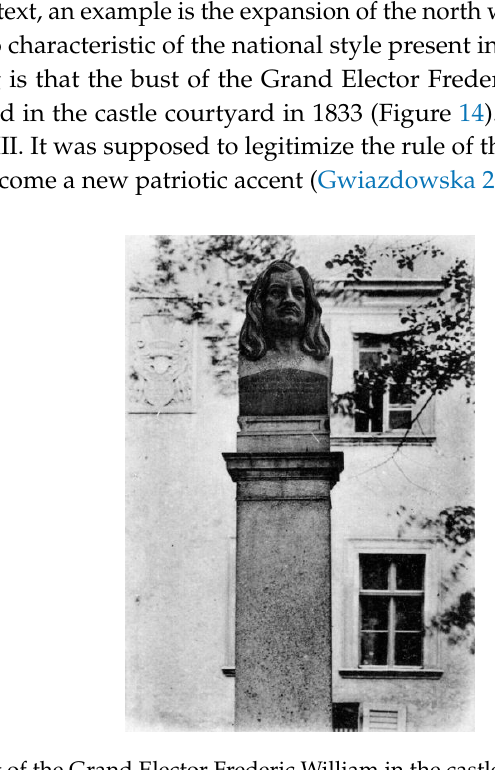
Figure 14. The bust of the Grand Elector Frederic William in the castle courtyard, source: sedina.pl.